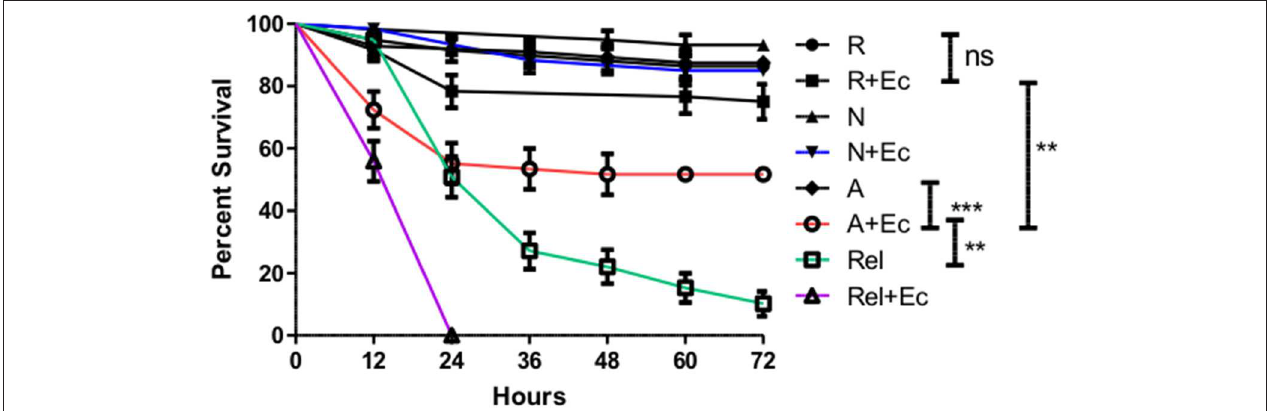
FIGURE 6 | Co-injection of Escherichia coli with activated Heterorhabditis bacteriophora nematode Excreted/Secreted (ES) products results in fly mortality. Adult Drosophila melanogaster were injected with 69.0 nl of a 1:4 mixture of OD 3.0 E. coli ( + Ec) and activated ES products (A), non-activated ES products (N), or Ringer’s buffer (R). After mixing, solutions contained 310 IJ equivalents of ES products and 8 × 10 4 CFUs of E. coli as applicable. Relish mutant flies (Rel) were also injected in order to compare the magnitude of ES-suppression to that of Immune deficiency pathway ablation. Survival was assessed every 12h for a total of 72h. Three trials were performed, each consisting of 10 male and 10 female flies per treatment. Where bars are omitted, standard error was negligible (ns p > 0.05, ** p < 0.01, *** p <